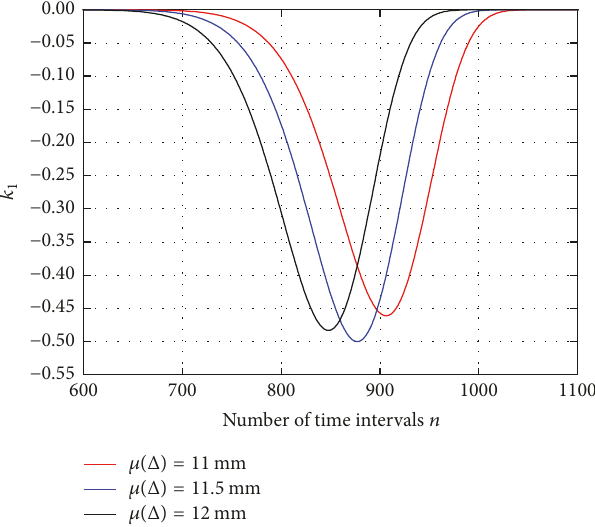
Figure 8: Sensitivity with respect to mean value of Δ .